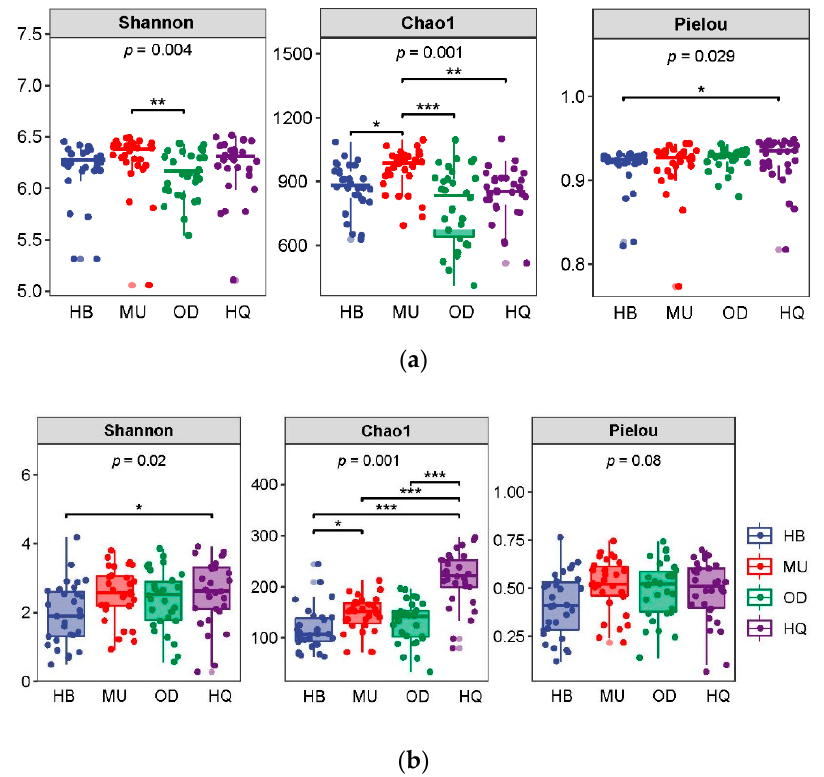
Figure 2. α diversity of soil bacterial ( a ) and fungal ( b ) communities in four sandy lands. (* p < 0.05;